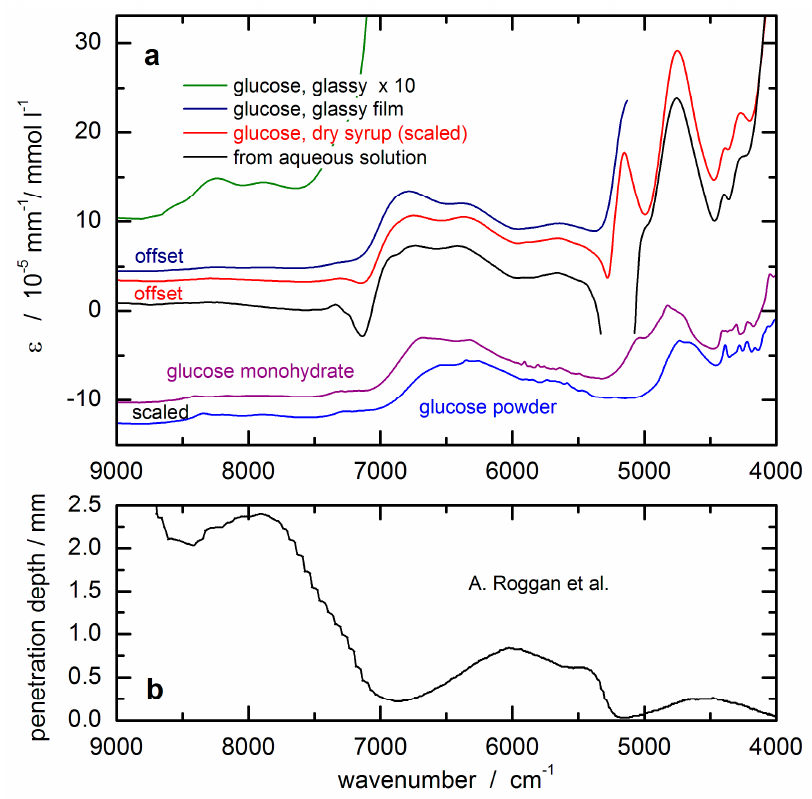
Figure 5. ( a ) Absorptivities of glucose calculated from transmission measurements of aqueous solutions and of glass-like sugars from dehydrated syrup sample (scaled to the aqueous solution phase absorptivities), as well as from glucose powder; ( b ) optical penetration depth based on radiation diffusion theory (from Roggan et al. [46]) used for scaling the glucose response spectrum for the noninvasive assay.